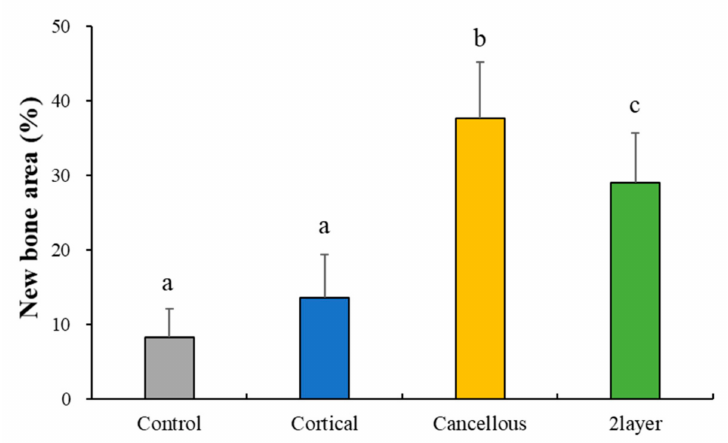
Figure 10. Histometric measurement of newly formed bones. Different letters denote significant differences among each group ( p <